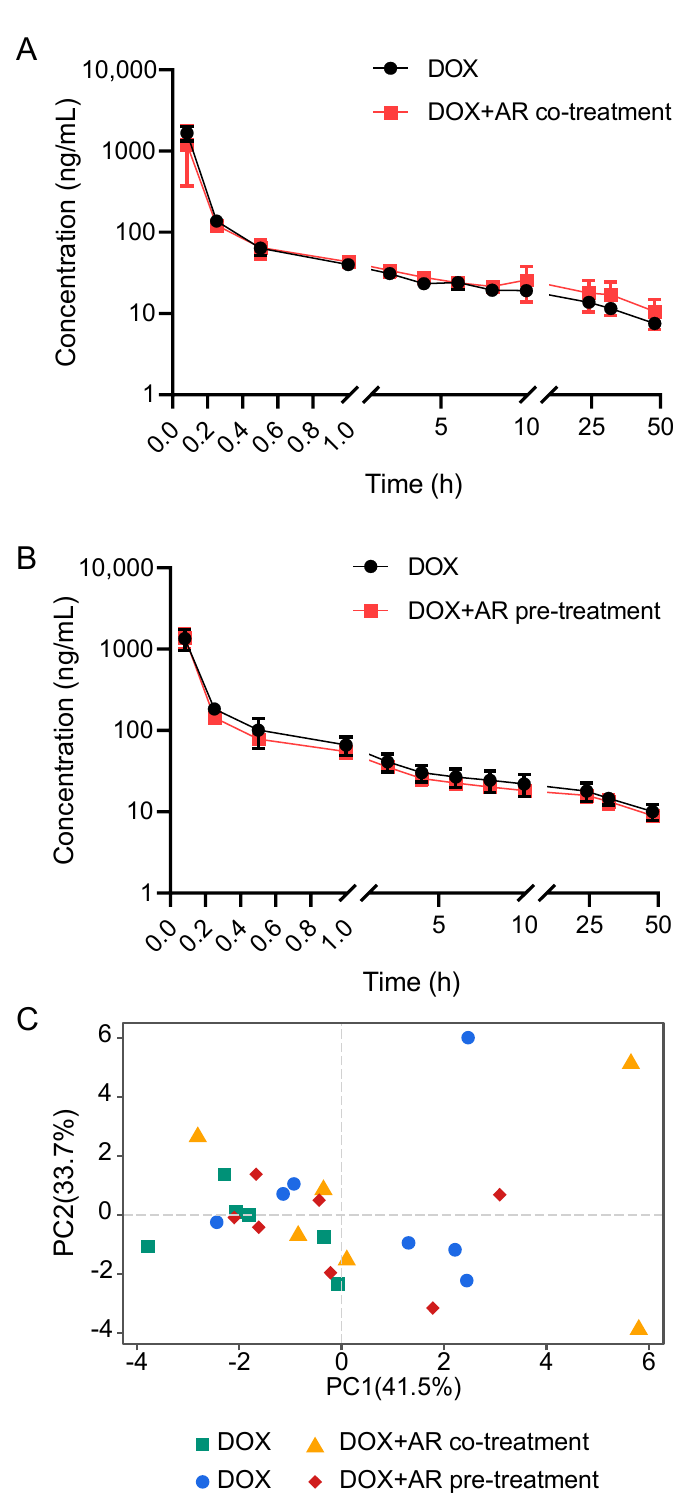
Figure 2. Astragali Radix (AR) does not affect the plasma pharmacokinetics of doxorubicin (DOX). ( A ) Mean plasma concentration–time curves of DOX after intravenous administration of DOX (5 mg/kg) alone and the co-treatment with AR (10 g/kg). ( B ) Mean plasma concentration–time curves of DOX after intravenous administration of DOX (5 mg/kg) alone and the pre-treatment with AR (10 g/kg × 10). ( C ) The principal component analysis score plot shows no clear separation among four groups of rats. All data are presented as mean ± SD.